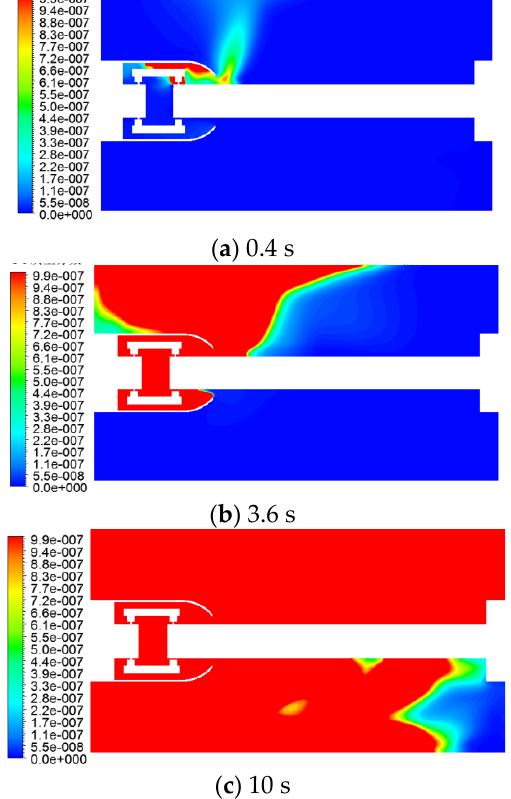
Figure 9. CO mass fraction variation law with time.